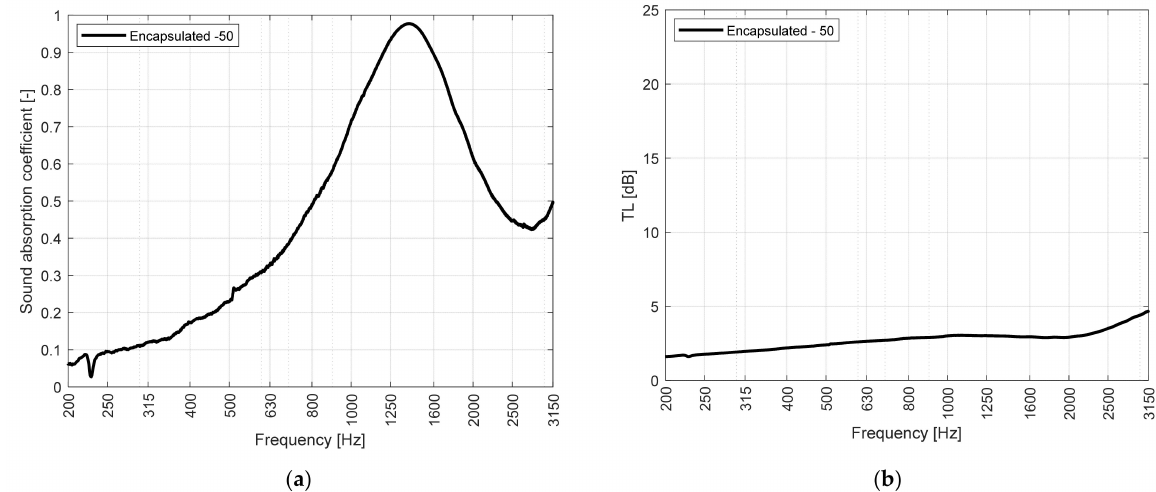
Figure 10. Acoustic properties of slag spheres encapsulated in inert material: ( a ) sound absorption coefficient; and ( b ) transmission loss.